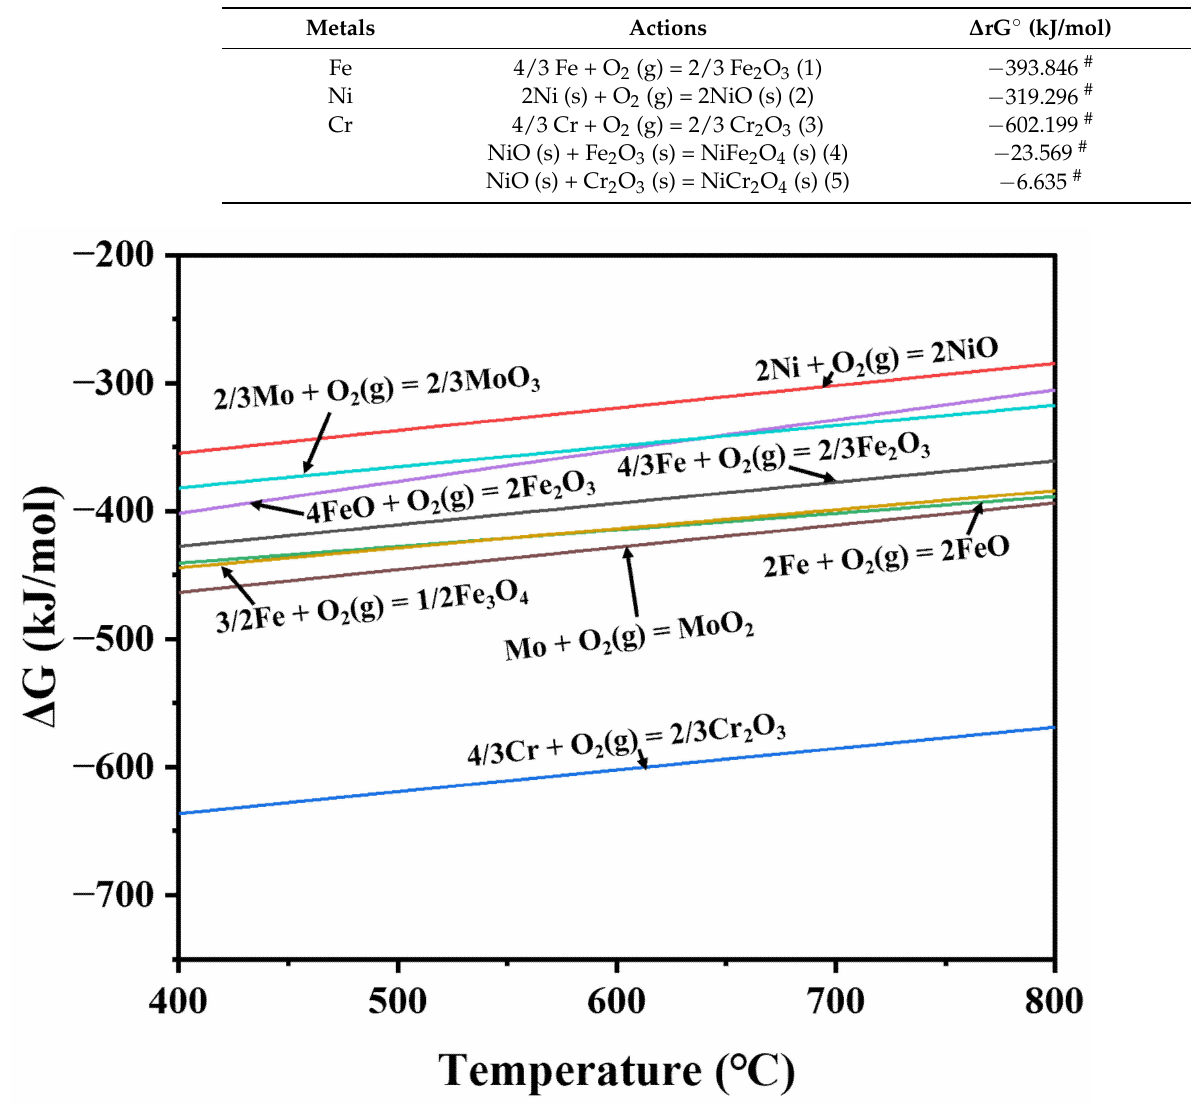
Table 4. Reactions for the oxidation of Fe, Ni, and Cr in Cr-Ni-Mo hot-work die steels at 600 ◦ C. The values of the standard Gibbs free energy changes of these reactions ∆ rG ◦ were calculated according to the thermodynamic data from HSC Chemistry version 6.0 database (#).